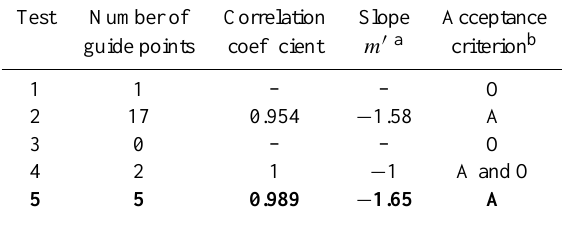
Fig. 010. Schematic representation of Step II. Fig. 10. Schematic representation of Step II. w 1 = 2 pixels, w 2 = 10 pixels, CRIT > max { m S · 0 . 77 , 1 } (K),